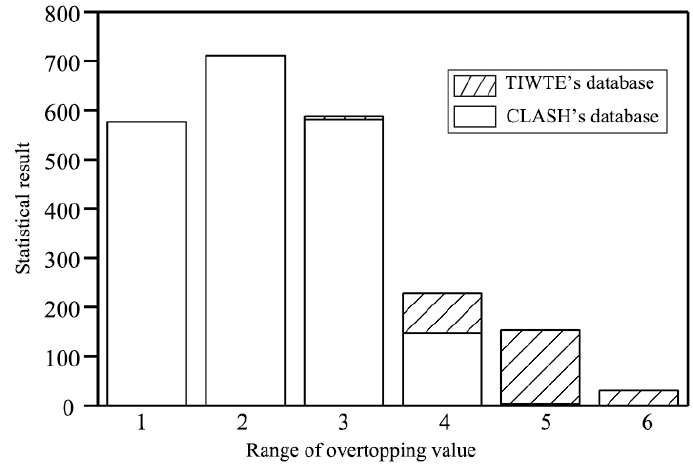
Figure 3. Statistical distribution of all datasets.